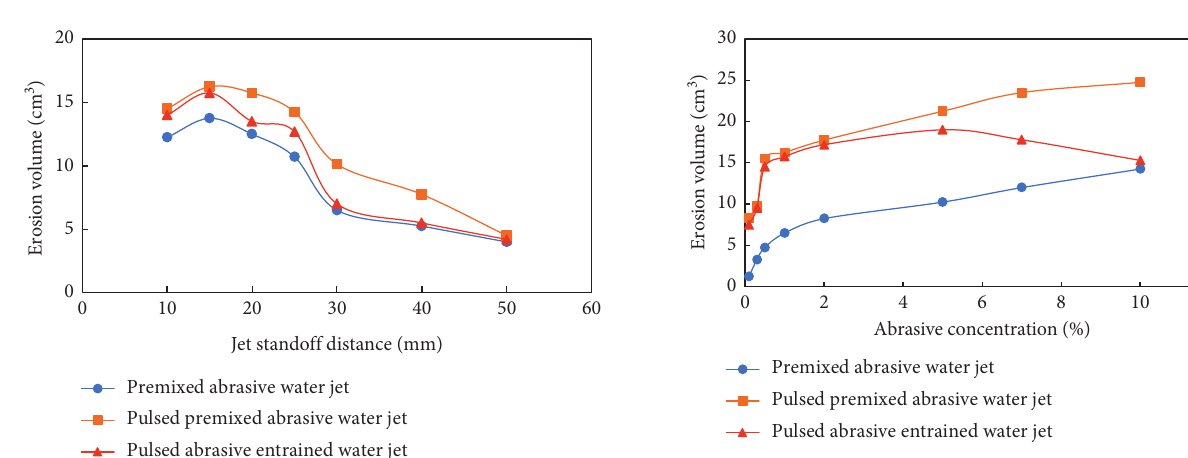
Figure 8: Erosion performance of the three kinds of abrasive water jets (when the pump pressure is 15 MPa and the jet standoff distance is 15